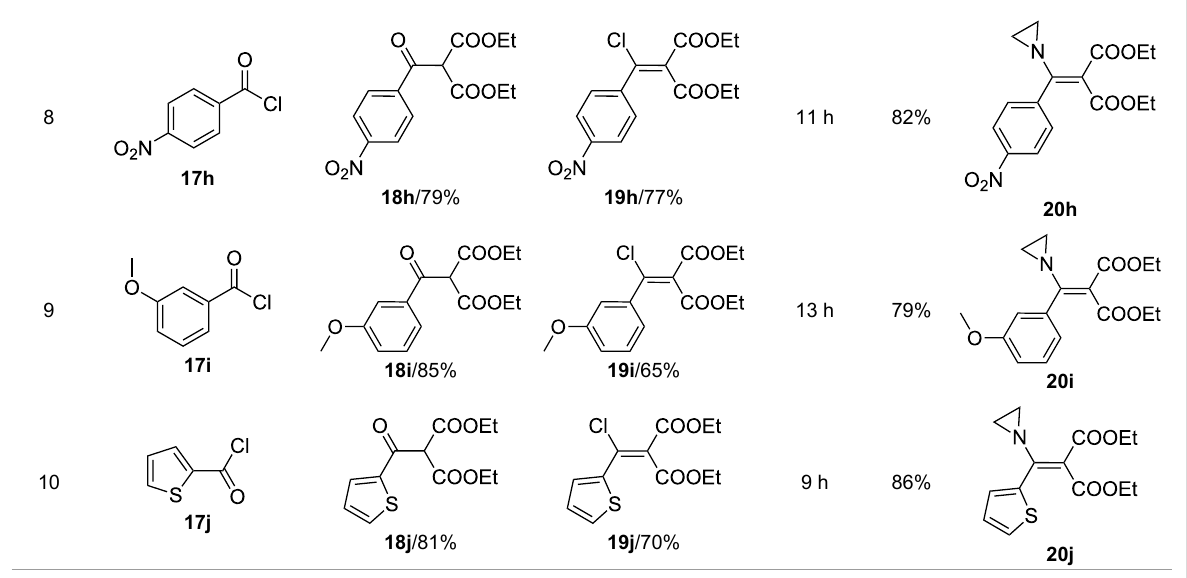
Table 1: Synthesis of N -vinylaziridines from diethyl malonate and acyl chlorides. (continued)